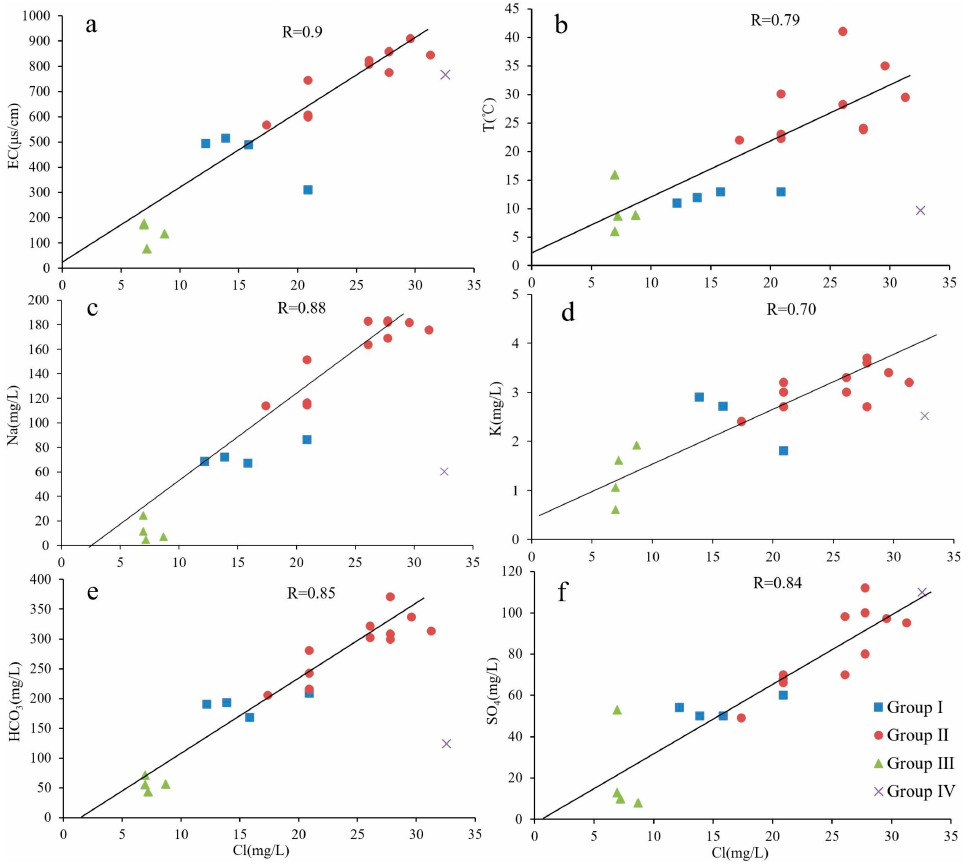
Figure 4. Plots of ion contents vs. chloride contents in the thermal and mineral water in Arxan ( a ) EC vs. Cl; ( b ) T vs. Cl; ( c ) Na vs. Cl; ( d ) K vs. Cl; ( e ) HCO 3 vs. Cl; and ( f ) SO 4 vs. Cl.